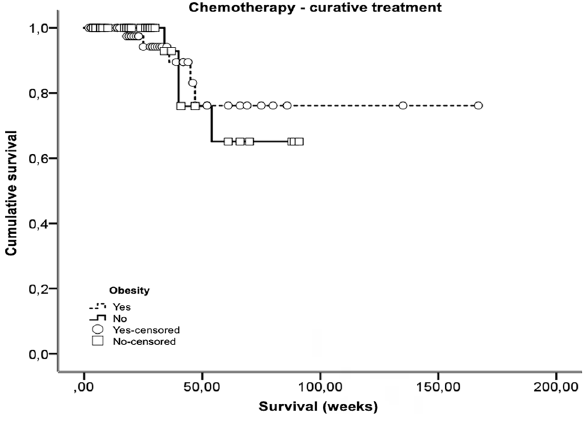
Image 10. Survival curve, in the Kaplan-Meier assessment, relating obesity to survival, among patients undergoing chemotherapy, with curative treatment intent Non-obese: mean of 136.29 weeks; Obese: mean of 4.30 weeks